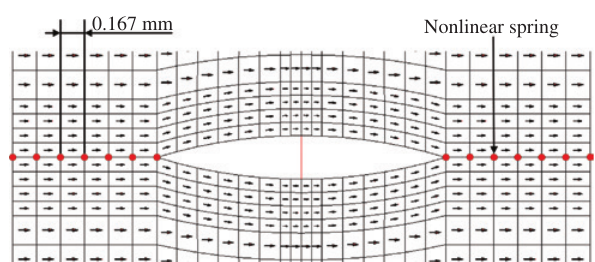
model. Figure 12: Distribution of nonlinear springs in the 6